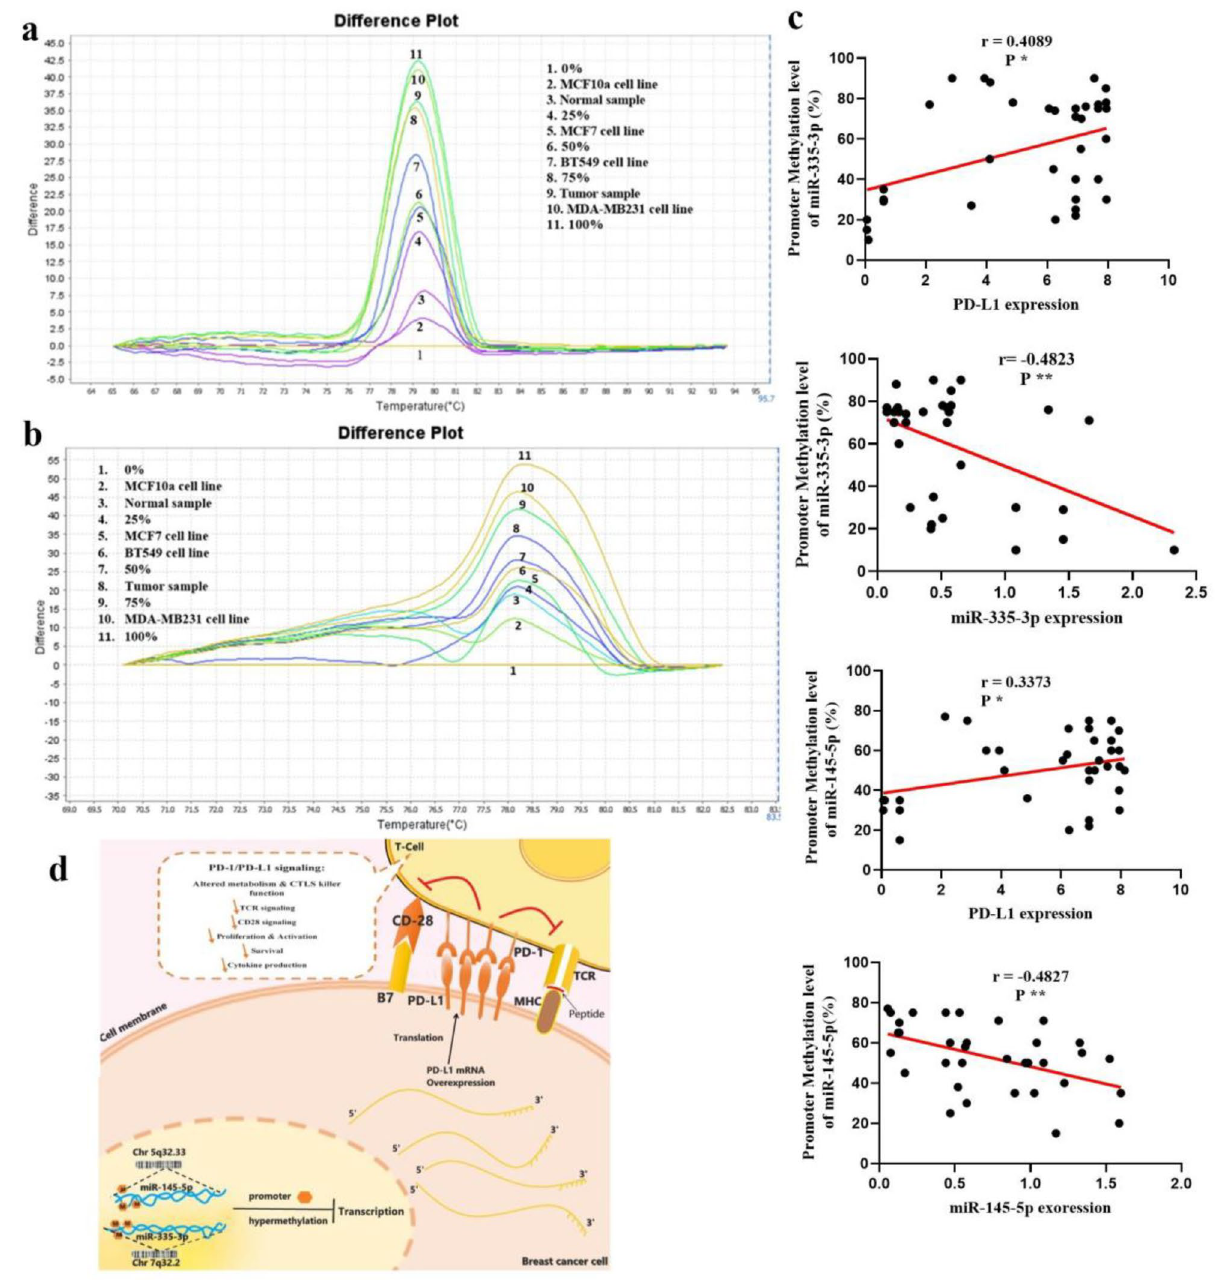
Figure 4. High-resolution melting of miR-335 and -145 genes. ( a ) Templates with different ratios (from 100 to 0%), some BC tissue samples, and methylated DNA cell lines were amplified by miR-335 and ( b ) miR-145 specific primers, and HRM analysis was done ( c ) Correlation analysis between the relative PD-L1 expression level and average methylation level of miR-335 and -145 promoters (r = 0.4089 and r = 0.3373, respectively, Pearson correlation). Relative miR-335 and-145 expression levels and the average methylation level of miR-335 and-145 promoters (r = − 0.4823 and r = − 0.4827, respectively, Pearson correlation) ( d ) A schematic showing how hyper-methylation of the miR-335 and -145 promoters can turn off T cells. In breast cancer cells, PD-L1 expression increases due to promoter hyper-methylation of PD-L1 tumor suppressor miRs, such as miR-335 and -145, and their lack of transcription. PD-L1, by binding PD-1, blocks the activation of T cells. *P ≤ 0.05, **P ≤ 0.01, ***P ≤